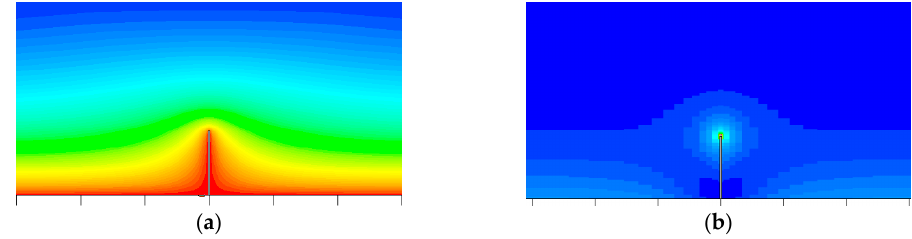
Figure 18. Simulation model (simu.2) results shown in close-up to a vertical surface crack with a depth of 1 mm. Material: non-magnetic steel, properties are listed in Table 1. The excitation frequency is 200 kHz. ( a ) Eddy current streamlines; ( b ) Joule-heating.